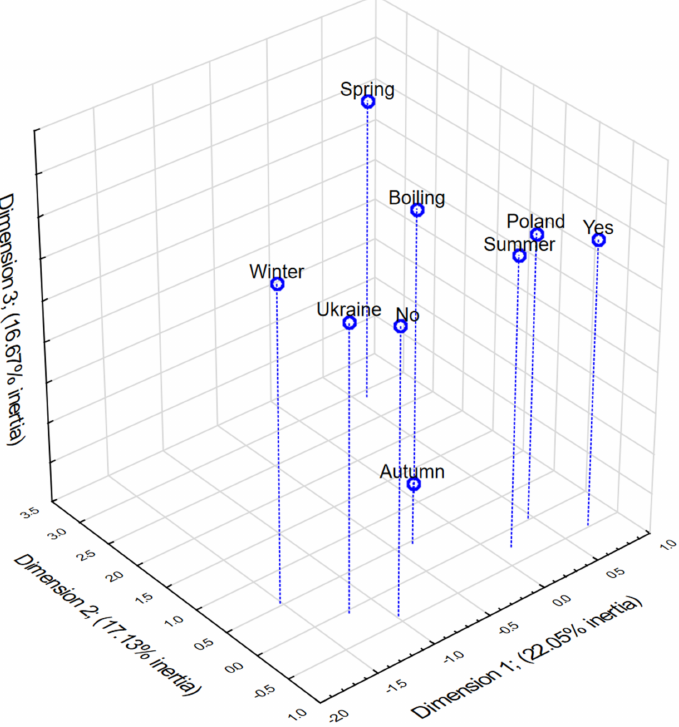
Figure 1. Three-dimensional column coordinate plot for country data, period of greatest tap water supply consumption and use of tap water directly for drinking without